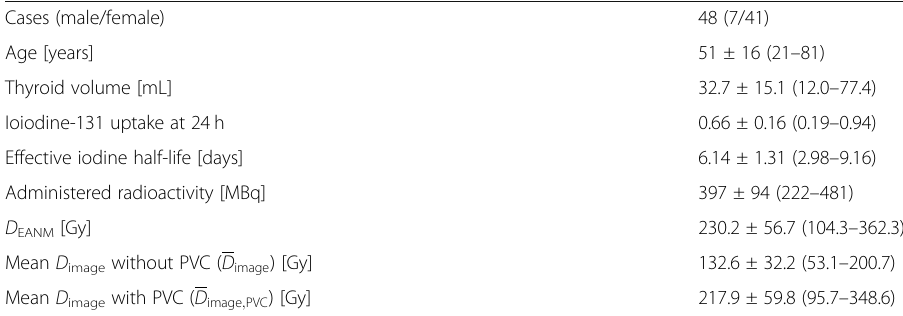
Table 1 Summary of study participant